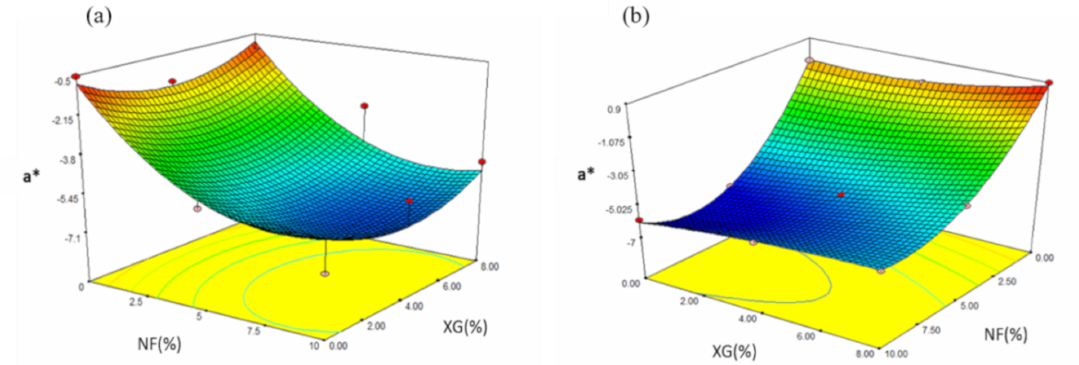
Figure 9. Effect of the interaction of fiber and rubber in parameter a* in snacks made with: ( a ) native starch and ( b ) starch modified by extrusion.